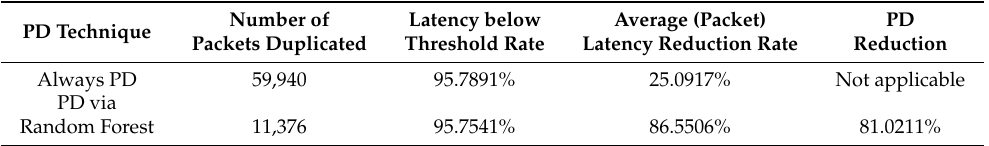
Table 4. Comparison results between static and dynamic